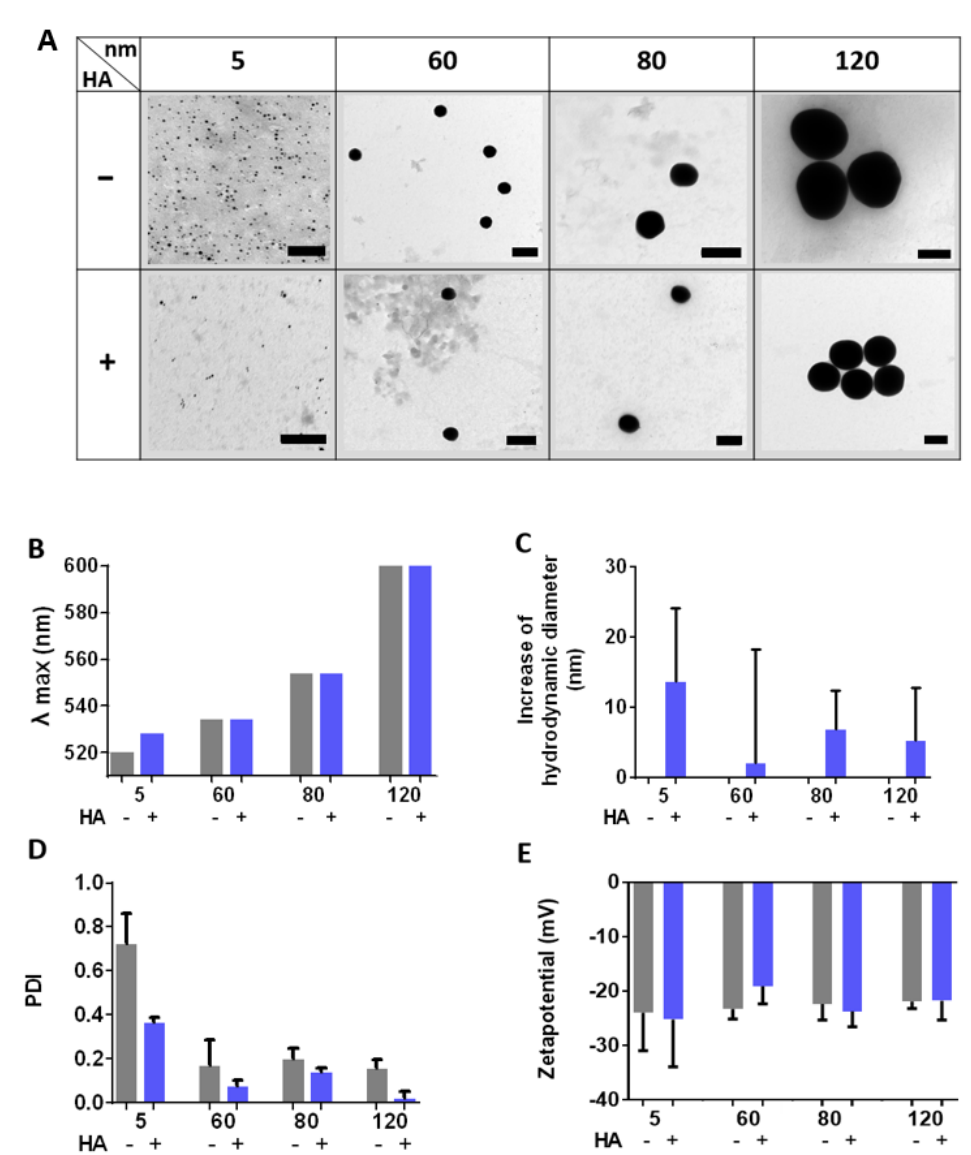
Figure 1. Physicochemical characterization of the AuNPs and HA-AuNPs. ( A ) TEM images demon- strated a spherical shape of all particles. The sizes of the AuNPs were 5.7 ± 3.7 nm, 60.8 ± 3.4 nm, 78.2 ± 4.6 nm and 119.0 ± 7.1 nm, respectively. The sizes of the HA-AuNPs were 5.1 ± 2.4 nm, 64.7 ± 2.5 nm, 88.6 ± 10.2 nm and 125.1 ± 9.3 nm, respectively. There was no considerable difference between the AuNPs and HA-AuNPs. The scale bar indicates 100 nm. ( B ) The SPR absorbance maximum of the particles showed a right shift with increasing particle size. For the AuNPs, the UV-maxima were 520 nm, 534 nm, 554 nm and 604 nm, respectively. For the HA-AuNPs, the UV- maxima were 528 nm, 534 nm, 554 nm and 606 nm. HA surface modification caused a right-shift of the UV-maximum only in case of the 5 nm AuNPs. ( C ) To illustrate the size increase after coating with HA, the difference in the hydrodynamic diameter between the HA-AuNPs and AuNPs was calculated. The hydrodynamic diameter differed by about 2 to 14 nm and was not statistically significantly different. ( D ) The polydispersity index (PDI) decreased with increasing size and after HA coating. ( E ) The zeta potential of all particle types was negative ( − 20 to − 25